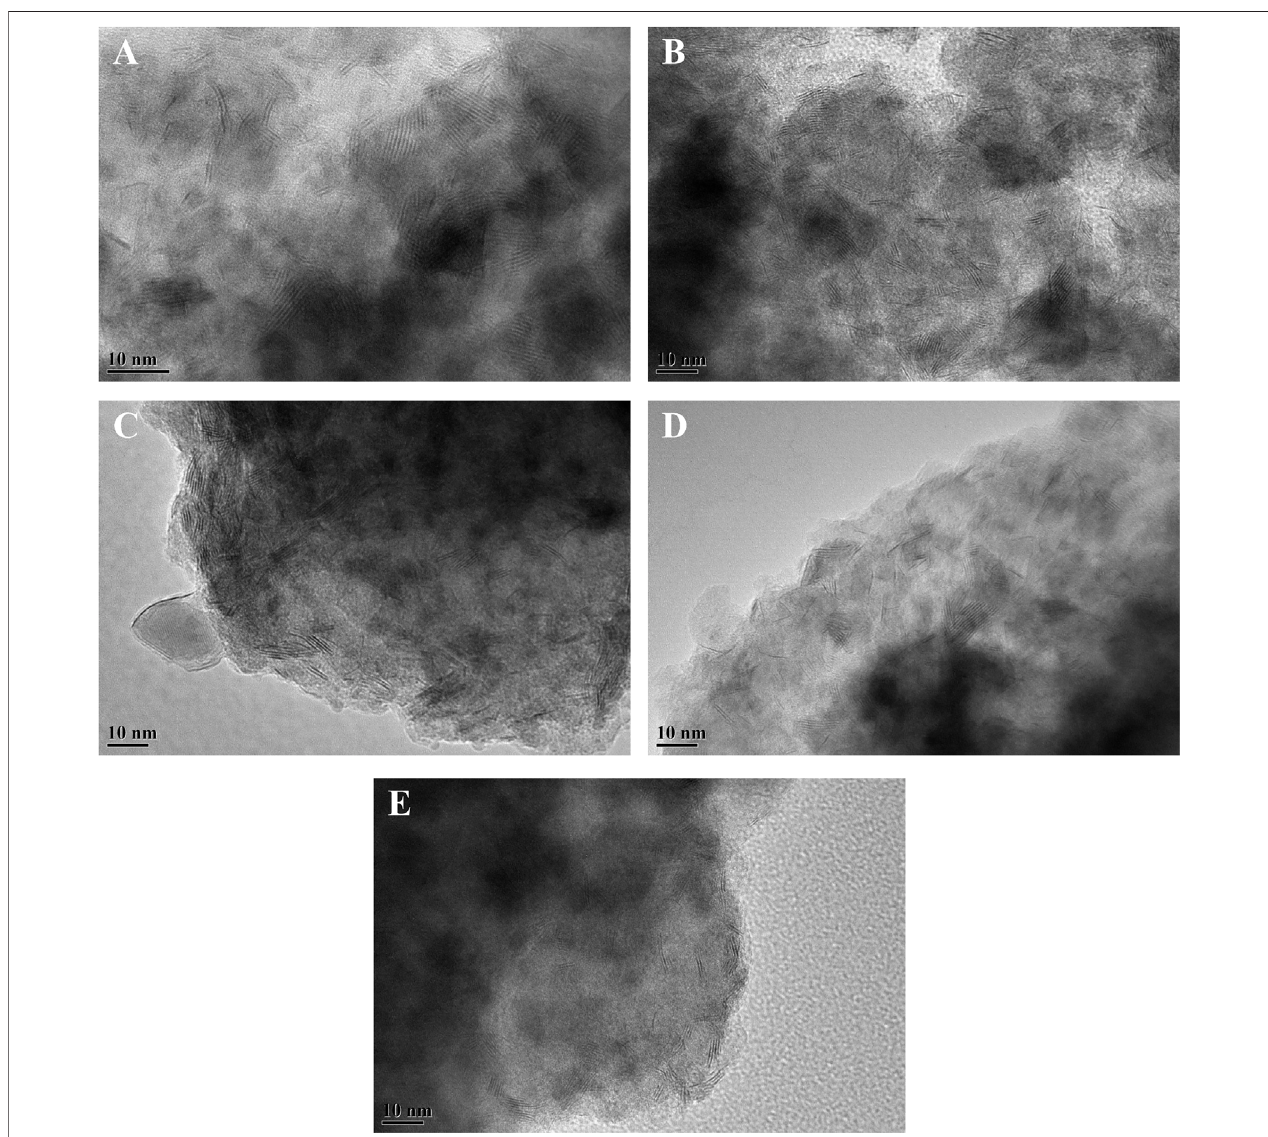
FIGURE 7 | Representative HRTEM images of sul fi ded catalysts: (A) NiW/4Ni-SAPO-11, (B) NiW/3Ni-SAPO-11, (C) NiW/2Ni-SAPO-11, (D) NiW/1Ni-SAPO-11, and (E) NiW/SAPO-11.